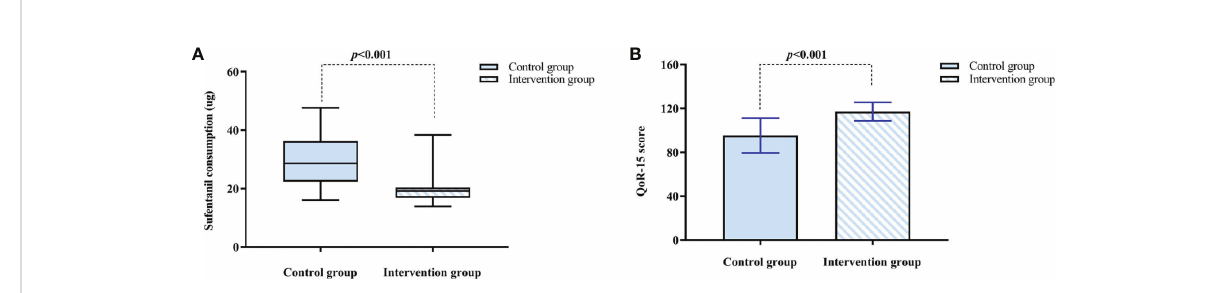
FIGURE 4 (A) Sufentanil consumption within 12 h after surgery. The results are reported as median (IQR). (B) The QoR-15 score at 48 h after surgery. The results are reported as means and SDs. The time to reach PACU is de fi ned as 0 h. QoR-15: 15-item quality of postoperative recovery.